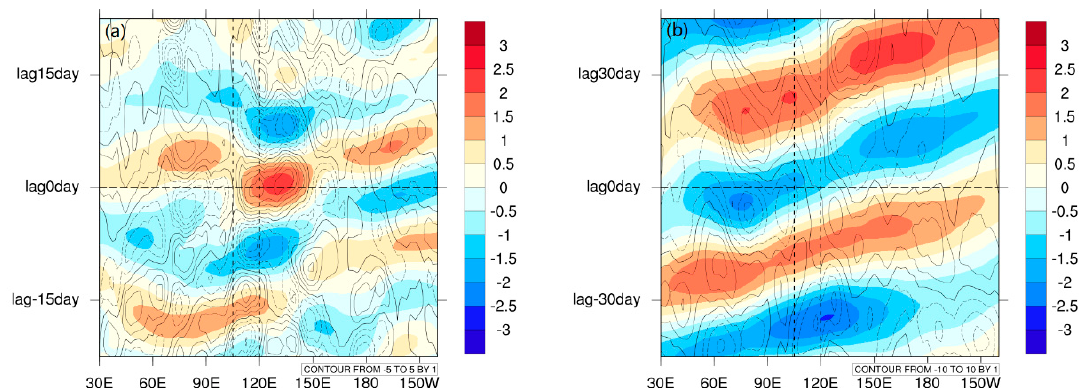
Figure 7. Composite time-longitude sections of outgoing long-wave radiation (OLR) anomalies {contours (dashed: negative, solid: positive), CI: 1 W m − 2 } and (200 hPa–850 hPa) velocity potential anomalies (shading, 10 6 m 2 s − 1 ) of all EHW events averaged between 30 ◦ S–30 ◦ N in association with ( a ) 10-to-30-day and ( b ) 30-to-90-day intra-seasonal variability. The “lag0 day” represents the start time of individual EHW events over our target area. The domain within two vertical dashed lines highlights our target area.